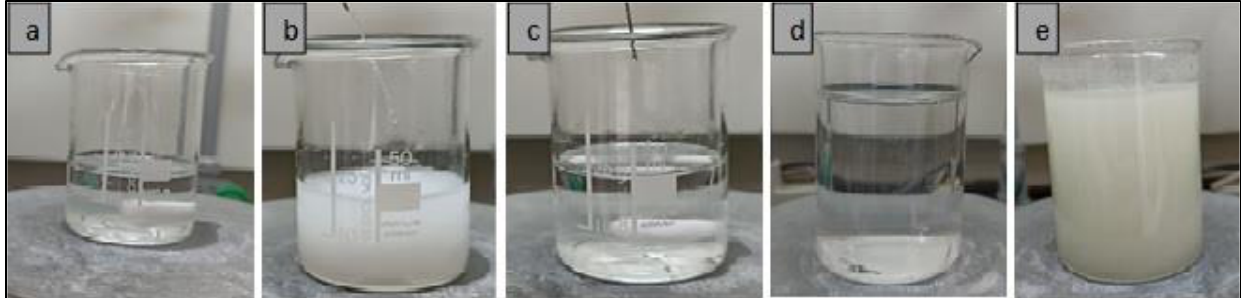
Figure 2 . Different stages of chemical bath solution where ( a ) aqueous solution of CdSO 4 , ( b ) imme- diately upon adding 1 mL of NH 4 OH, ( c ) after adding the appropriate amount of NH 4 OH, ( d ) after adding H 2 O 2 and distilled water, and ( e ) after 3 – 5 min of heating to 50 °C.